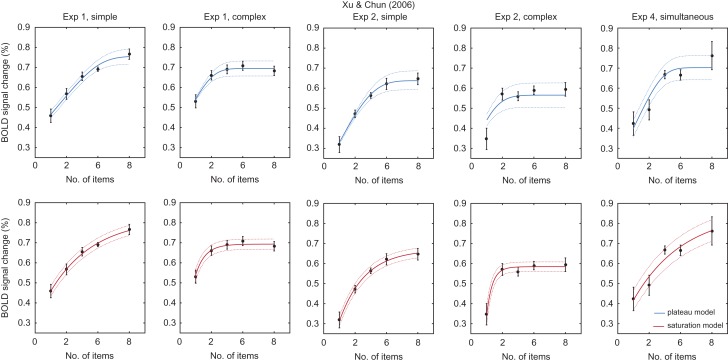
Fits to data from Xu & Chun (2006). Black data points show group-level fMRI response functions recorded from the same posterior parietal coordinates identified by Todd & Marois (2004). Errorbars indicate ±1 SE. Solid lines indicate fits of the plateau model (top, blue) and saturation model (bottom, red) to group means, dotted lines indicate SEs predicted by the models. Panel titles indicate the experiment number and whether memory stimuli were simple or complex; for Exp 4, we examined only data from the simultaneous presentation condition (matching the other studies).